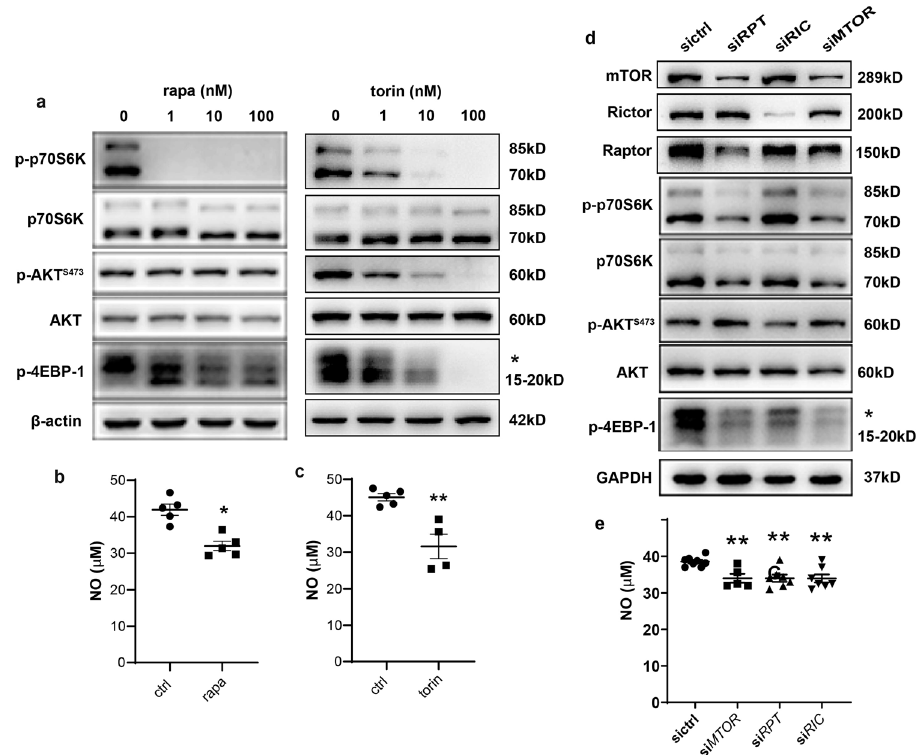
Fig. 2 Both mTORC1 and mTORC2 contributed to NO bioavailability in HAEC. a HAEC were treated with rapamycin (rapa) or torin 1 (torin) at indicated dose for 1 h prior to western blotting. *indicated the phosphorylated 4EBP-1. b , c NO levels of rapa ( b ) or torin-treated ( c ) HAEC were measured with colorimetric reaction assay. d , e At 48 h post transfection with control siRNA (sictrl), siRNA targeting RPTOR (siRPT), RICTOR (siRIC) or MTOR (siMTOR) , HAEC were submitted to western blot analysis ( d ) or NO measurement with colorimetric reaction assay ( e ) ( n = 5 – 7). Shown images are representative blots of at least fi ve experiments. * p < 0.05; ** p < 0.01 vs. ctrl or sictrl; unpaired two-tailed t test ( b , c ) or one-way ANOVA with Dunnett ’ s post-test ( e